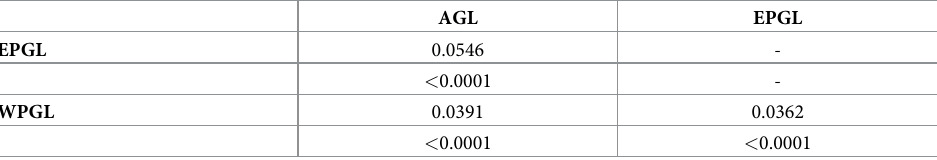
Table 2. Results of the CVA analysis with Procrustes distances and their respective p-values between genetic line- ages. Eastern Pacific (EPGL); Western Pacific (WPGN) and Atlantic